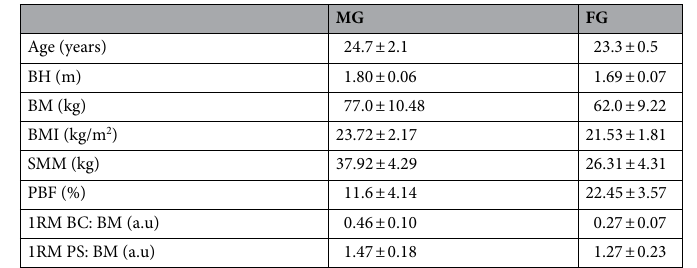
Table 1. Sample characteristics for males (MG) and females (FG). BH body height, BM body mass, BMI body mass index, SMM skeletal muscle mass, PBF percent of body fat, 1RM BC BM—biceps curl one